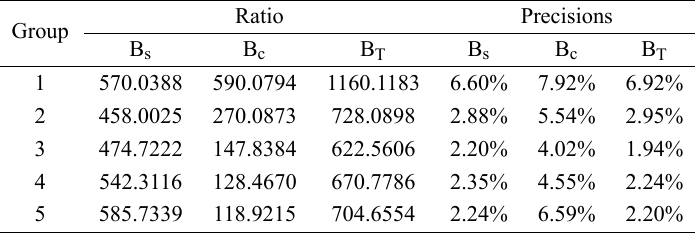
Coefficients and precisions obtained through procedure 3 to model the biomass of the components and total biomass as a function of the stem volume in stands of black wattle in the state of Rio Grande do Sul, Brazil. Ratio Precisions Group B s B c B T B s B